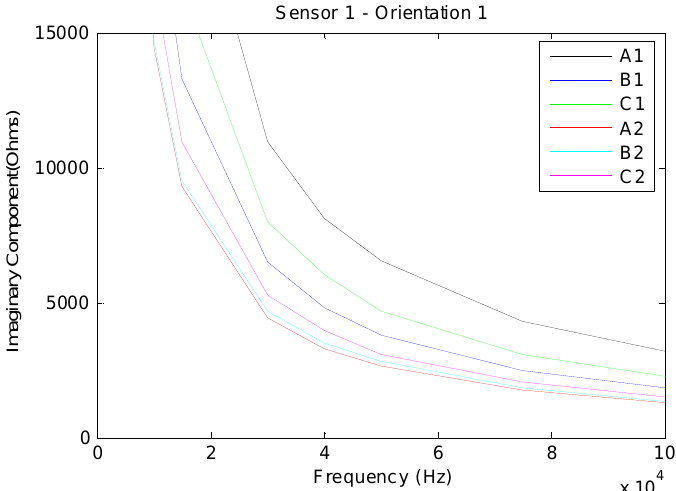
Figure 36. Sensor 1 characteristics for pork belly samples at orientation 1.